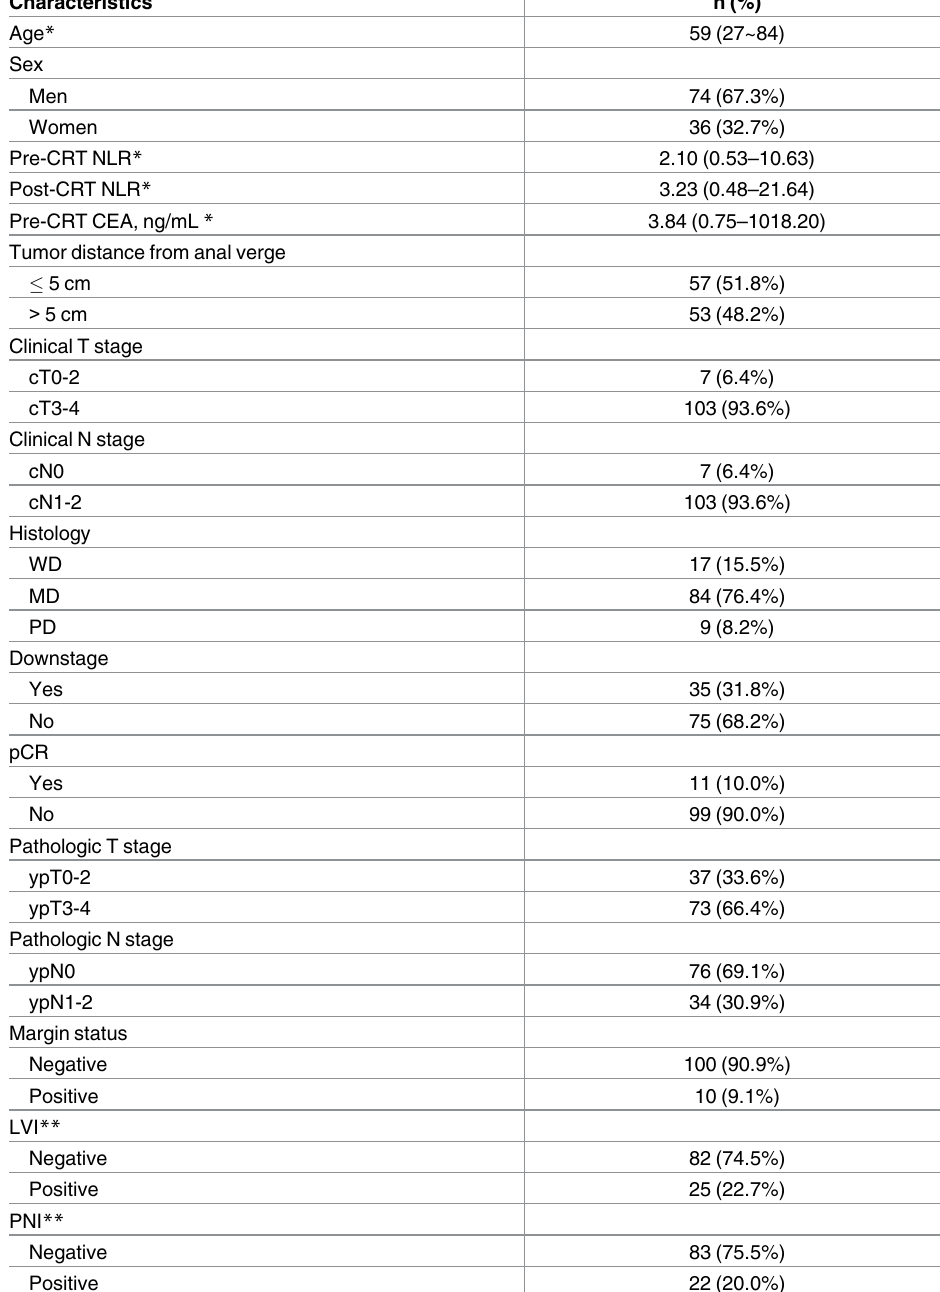
Table 1. Clinicopathologic